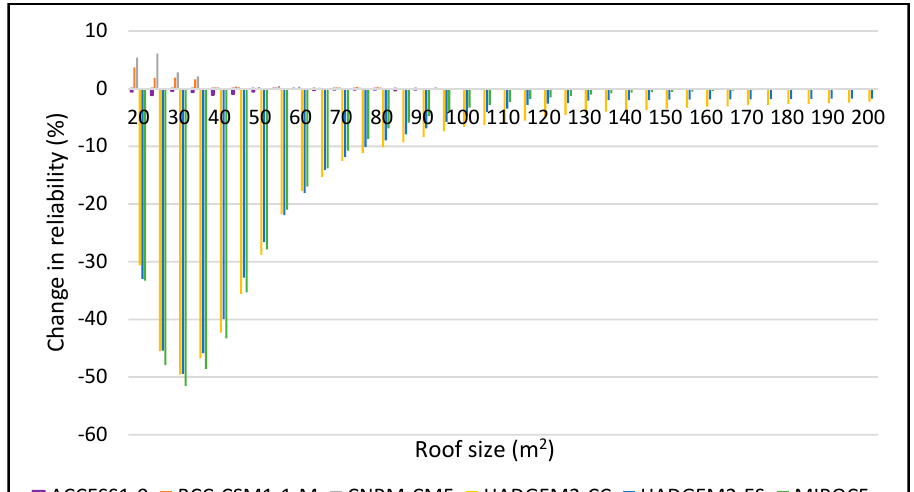
Figure 26. Change in reliability for MAM 2060–2090 period for 2 m 3 tank size.